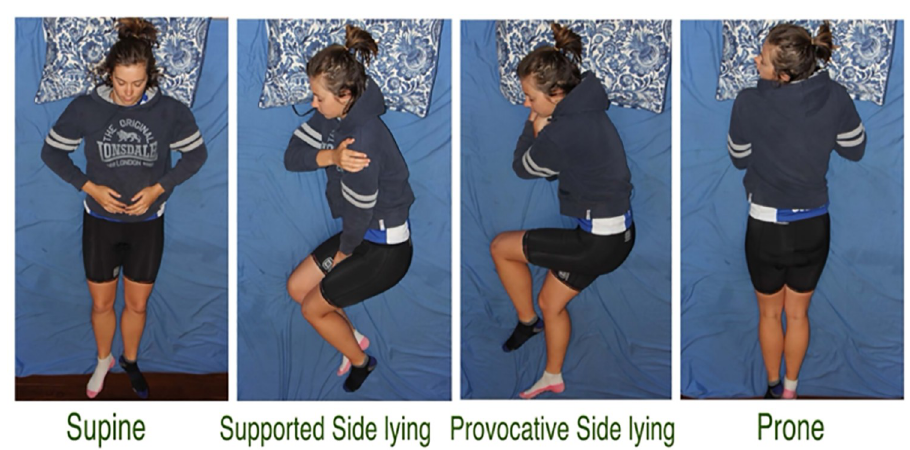
Fig 1. Sleep posture classification based on plausible spinal load. Sustained postures like rotation, have been identified as causing tissue microdamage and muscle spasms.